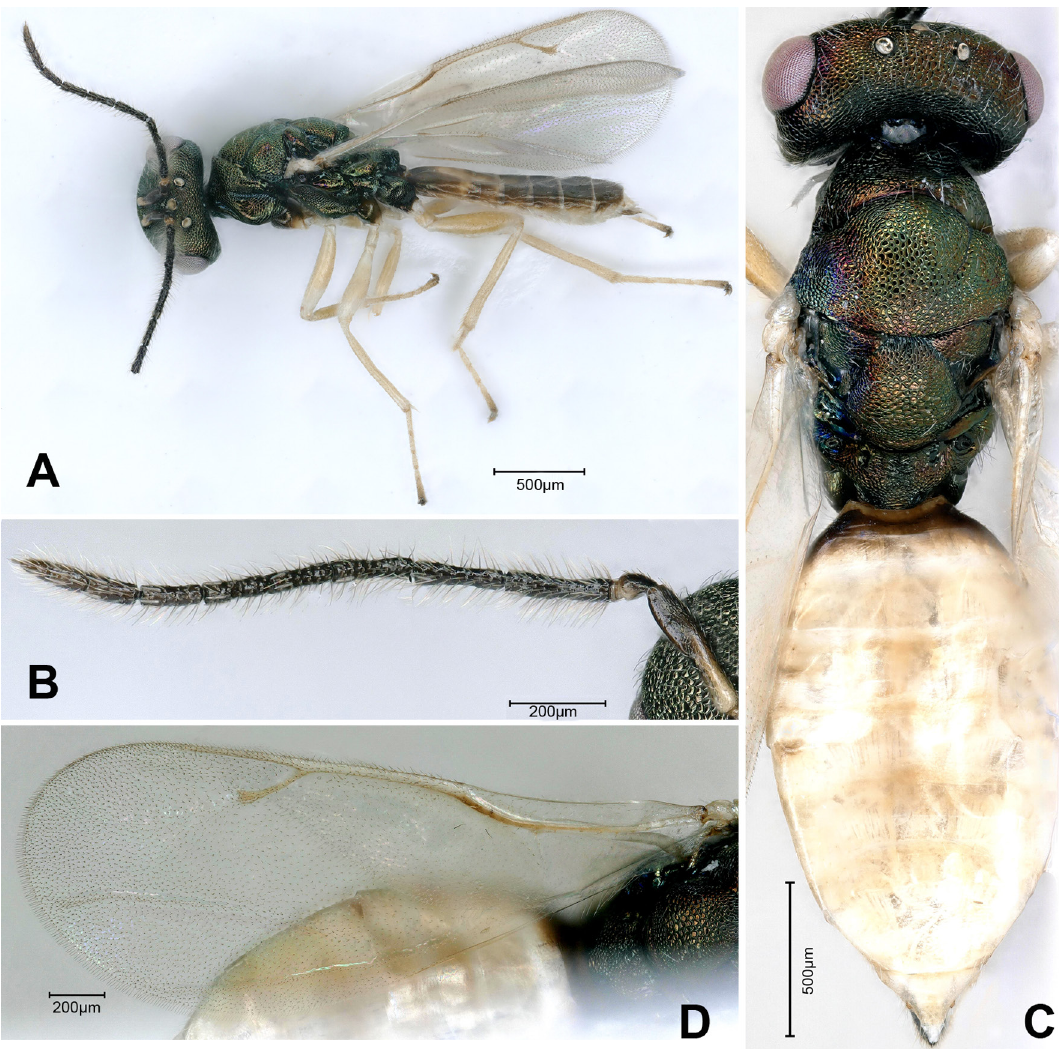
Fig. 12 . Homoporus febriculosus (Girault, 1917). A . Male in lateral view. B . Male antenna. C . Female in dorsal view. D . Fore wing of